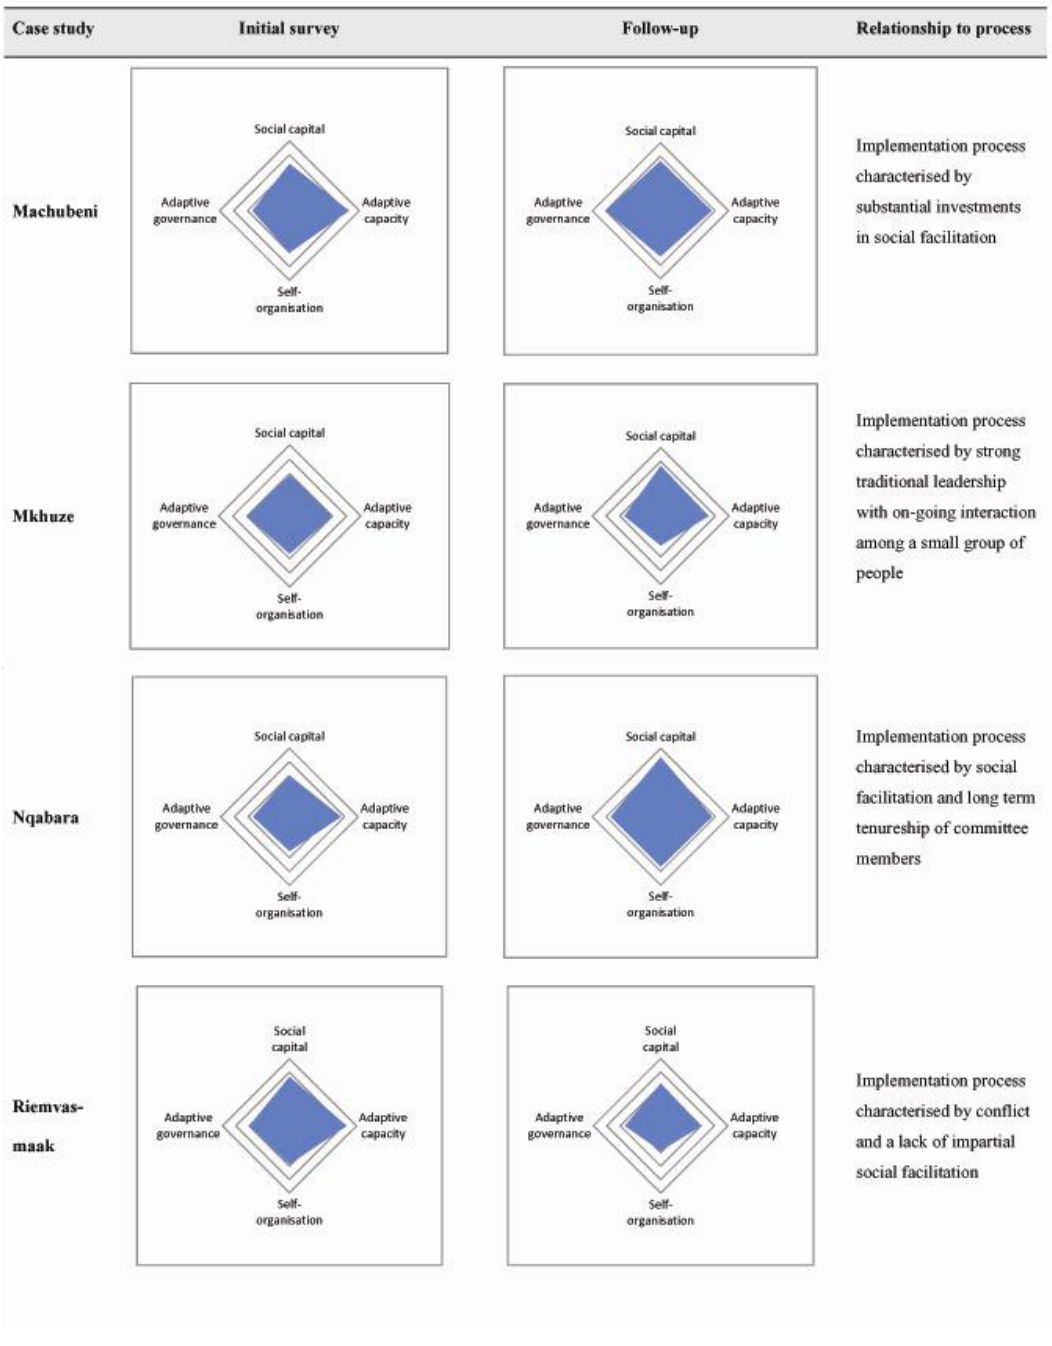
Fig. 2. The nature of change in each case study. Change is calculated as the sum of the ratings applied to variables relevant to each system attribute, divided by the maximum possible ratings for those variables. Axes represent a range from 0 to